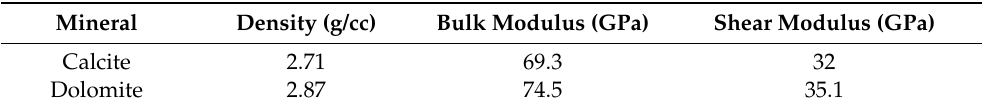
Table 1. Reservoir elastic